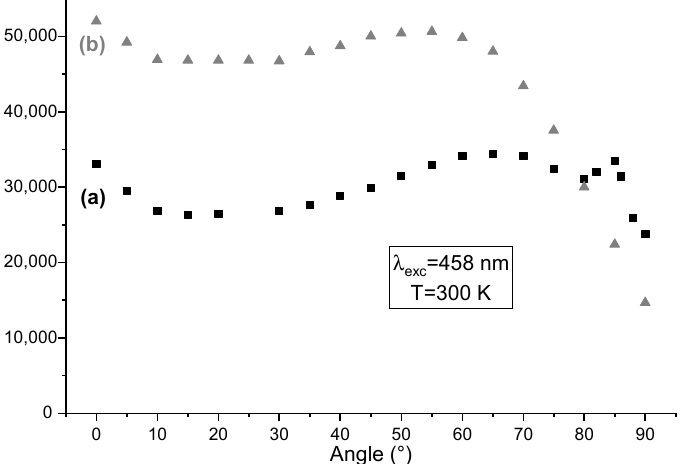
Figure 5. Room temperature angle-dependent emission intensity under a 458 nm excitation of ( a ) YAG:Ce alone and ( b ) YAG:Ce with ZnO NWs. Excitation source strikes the sample perpendicularly in its back (corresponds to 0°).